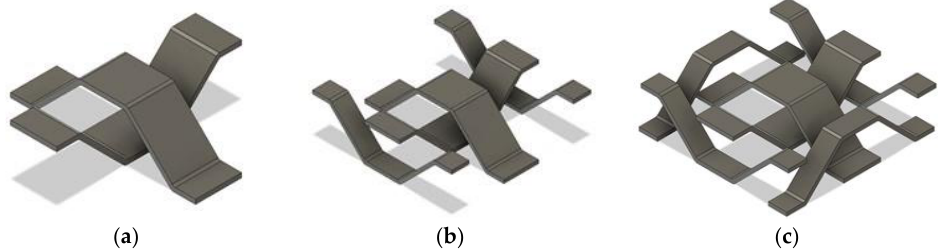
Figure 2. Bi-directional Navtruss Core geometry development, (a) 2 Strut Core. (b) 3 Strut Core, (c) 4 Strut Core